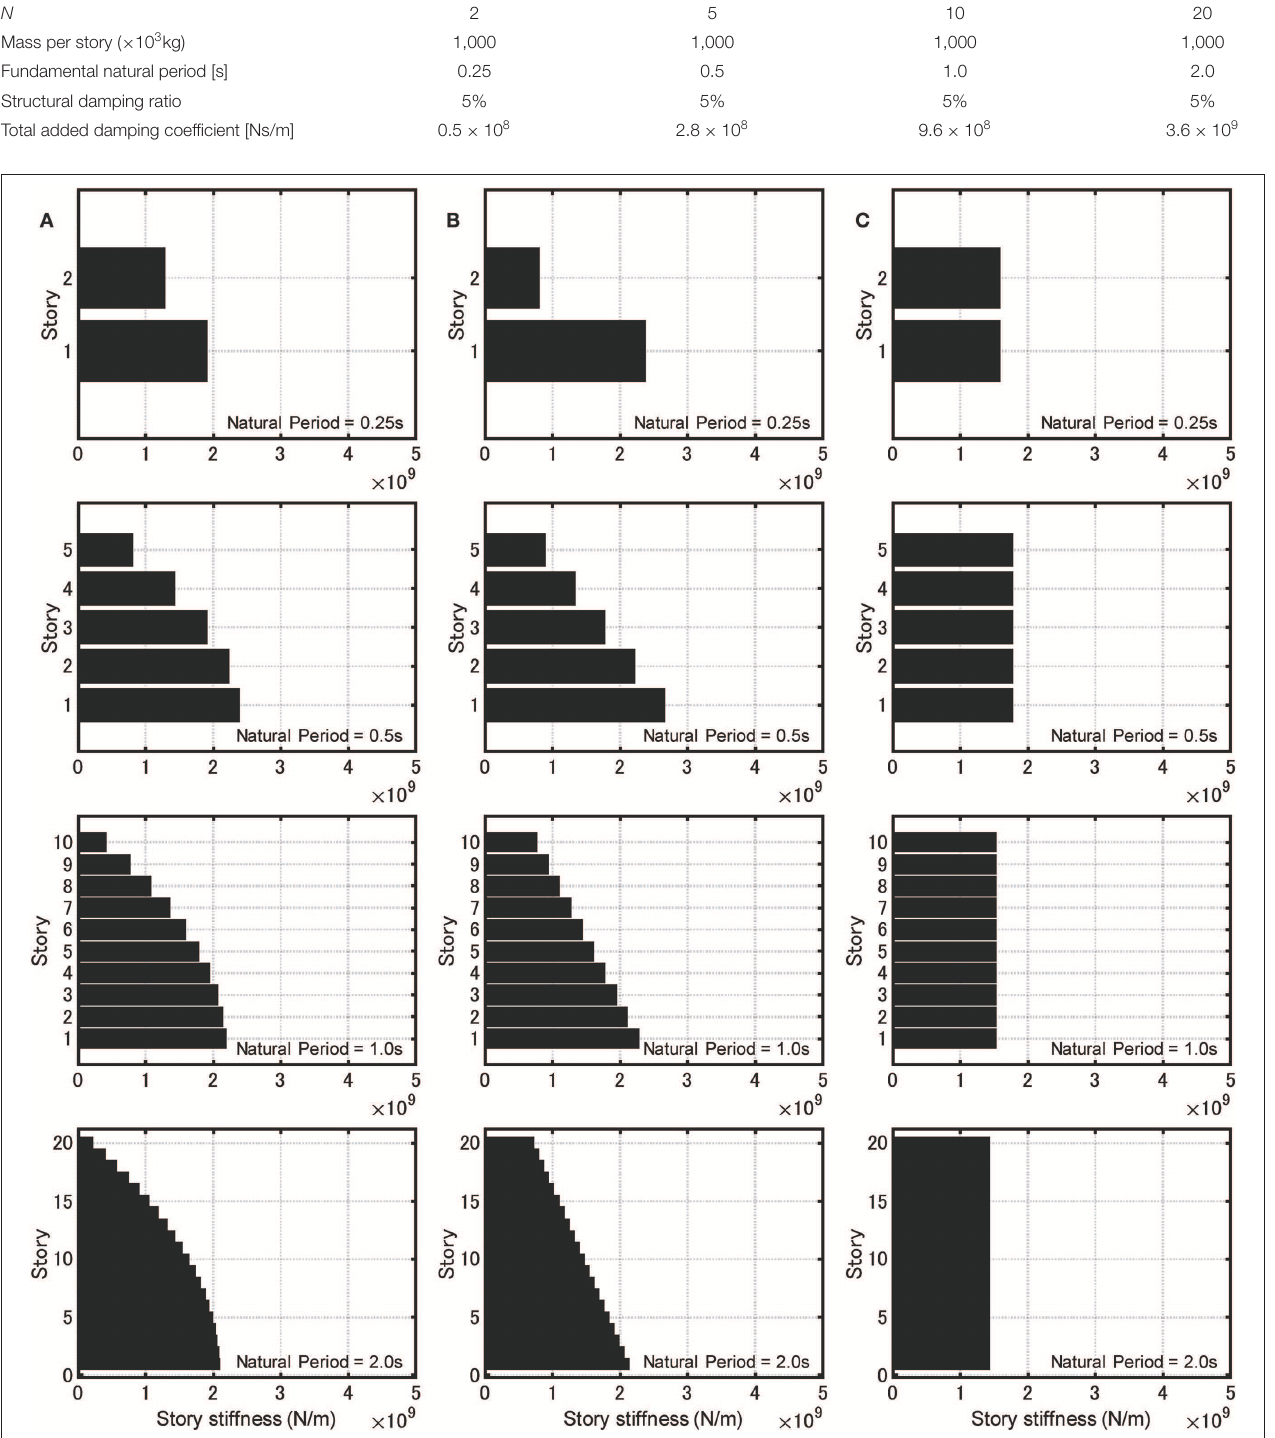
FIGURE 4 | Story stiffness distributions of three building structures. (A) Model with straight lowest natural mode. (B) Model with trapezoidal stiffness distribution. (C) Model with uniform stiffness distribution.